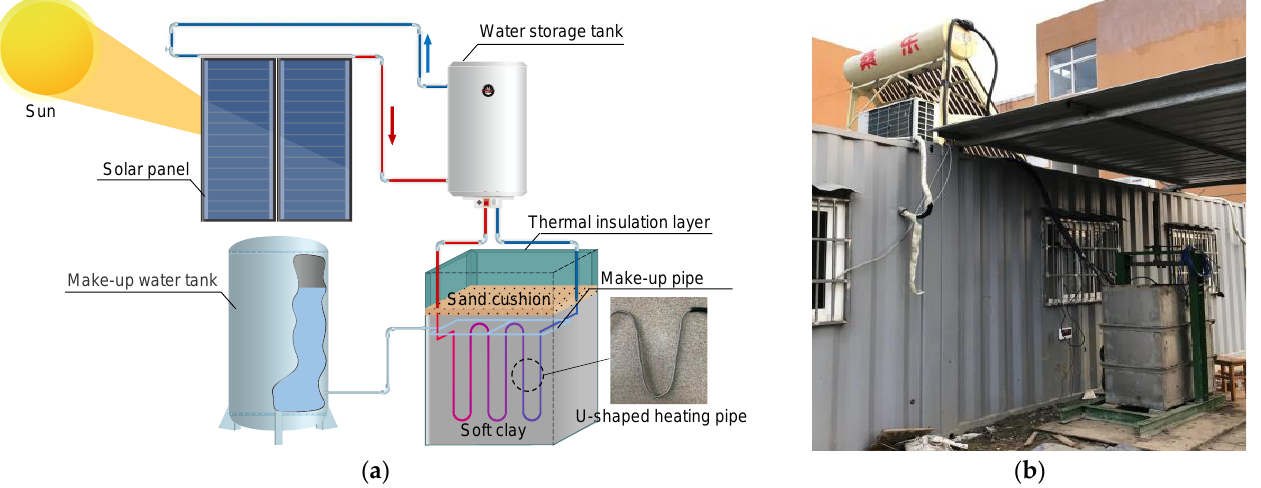
Figure 2. Schematic diagram of test model device. ( a ) Schematic diagram of test model device; ( b ) physical diagram of the test model device.